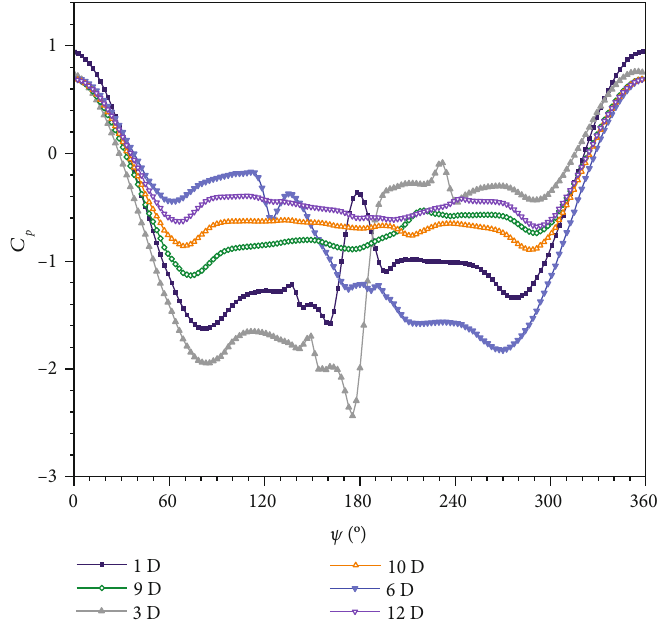
Figure 42: The pressure coe ffi cient of di ff erent sections varies with the roll angle at Model 2 with R a = 0 : 8 μ